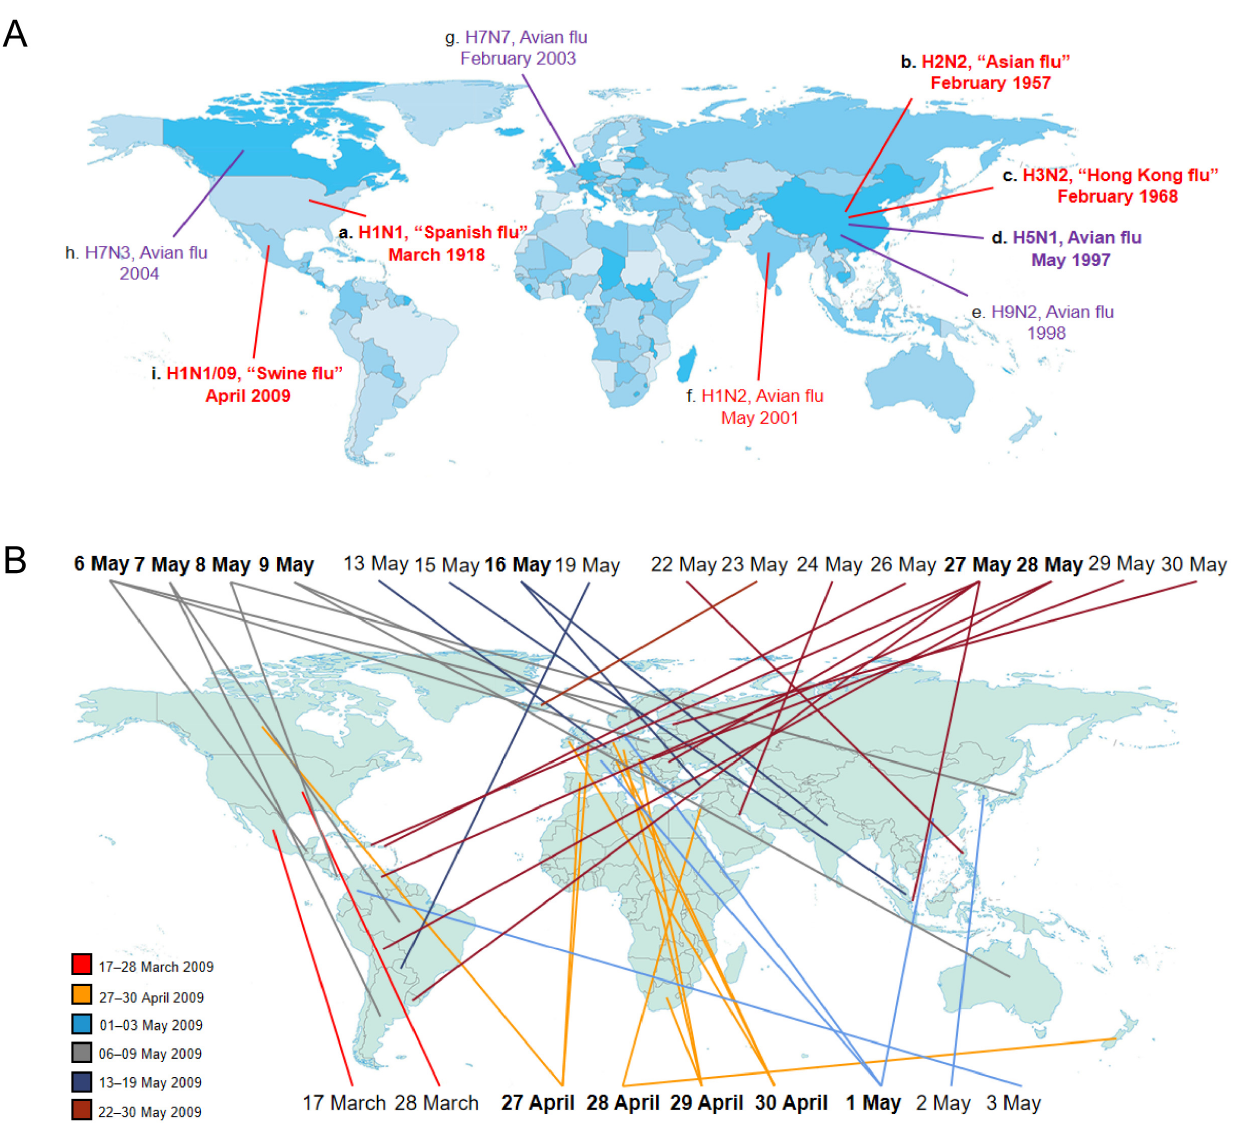
Figure 1. Chronological distribution of influenza A variants and sub-types. ( A ) Human flu viruses (in red) and five avian flu viruses (in purple) capable of infecting humans. The different colors on the world map (from light to deep blue) are here to show the different geographical areas or countries. The time when the virus first appeared in this world is mapped out. Lowercase letters (a–i) display the order in which the influenza A viruses appeared. The four human flu viruses (H1N1, H2N2, H3N2, 2009 H1N1) in bold indicate that they have caused global pandemics, posing a serious threat to human health. H5N1 avian flu virus in bold suggests that it arouses global concern as a potential pandemic threat. ( B ) The first reporting of 2009 H1N1 virus. The first confirmed cases were documented in Mexico on 17 March 2009. Then, the human outbreak of 2009 H1N1 virus rapidly spread to other countries within 2–3 months (from 17 March to 30 May 2009). The six colors of lines stand for different time periods individually. The twelve dates in bold represent that the virus was simultaneously showing up in two or more places in the world.